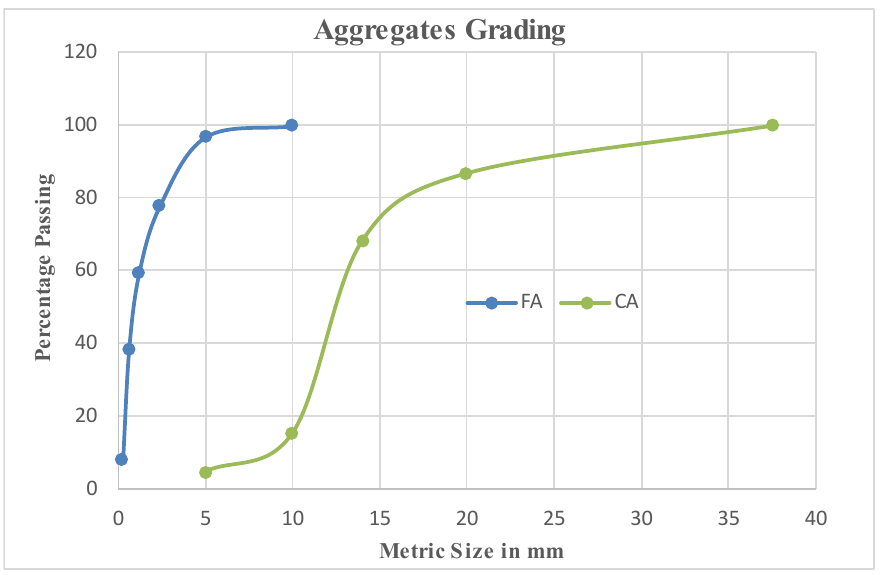
Figure 1. Grading curve of FA and CA. Table 4. Mixture proportions of concrete (kg/m 3